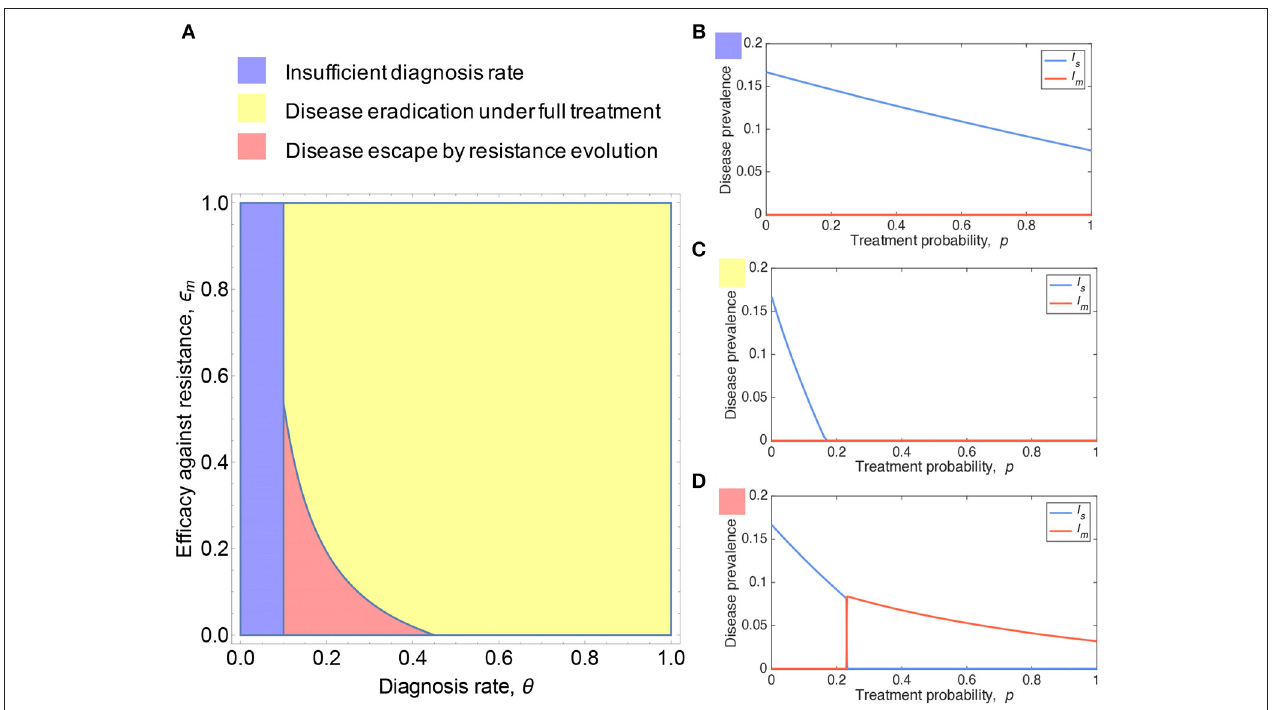
FIGURE 2 | Resistance evolution and antibiotic usage. (A) Shown is the parameter region of presentation rate θ and efficacy against resistance ǫ m under which antibiotic resistance can emerge. (B–D) plot the prevalence of sensitive and resistant strains as a function of treatment probability p . Resistance can be favored under sufficiently high treatment coverage and as a consequence, the tragedy of the commons in antibiotic overuse can occur. Parameters: b = 0.1, β s = 0.3, β m = 0.26, γ